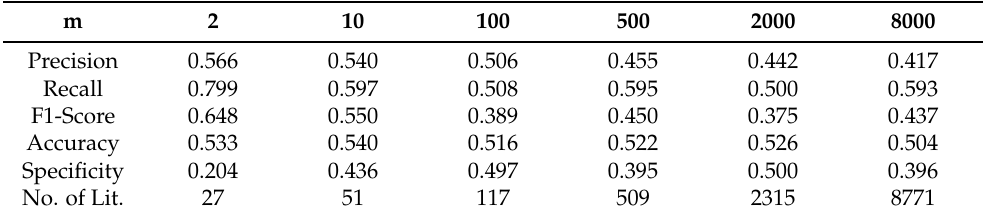
Table 17. Performance of TM with Booleanized continuous features on Liver Disorders dataset.